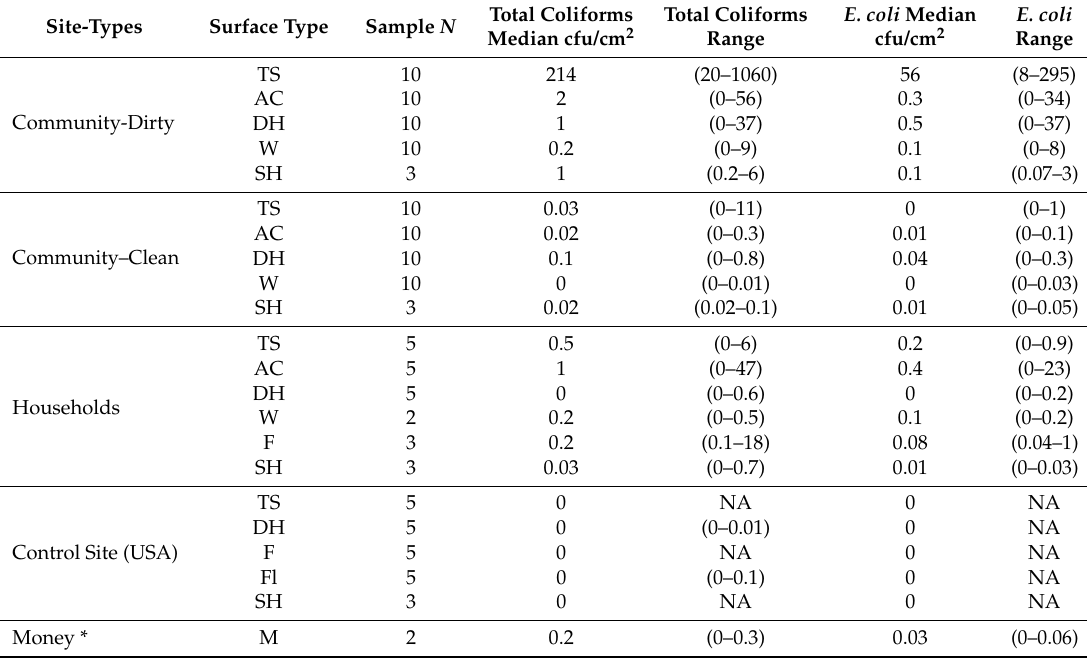
Table 2. Bacterial concentrations on latrine surfaces at community and household